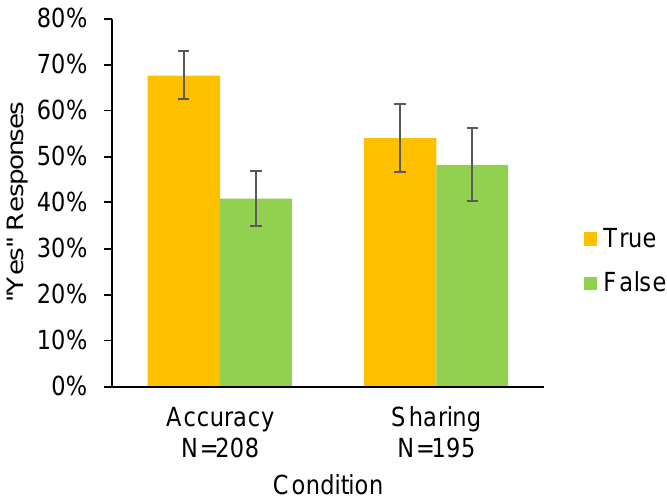
Figure 1. Disconnect between accuracy judgments and sharing intentions. Fraction of true versus false headlines rated as accurate in the Accuracy- Only condition (“To the best of your knowledge, is the claim in the above headline accurate?”) and considered for sharing in the Sharing co ndition (“Would you consider sharing this story online (for example, through Facebook or Twitter)?”) of survey wave 1. Error bars indicate 95% confidence